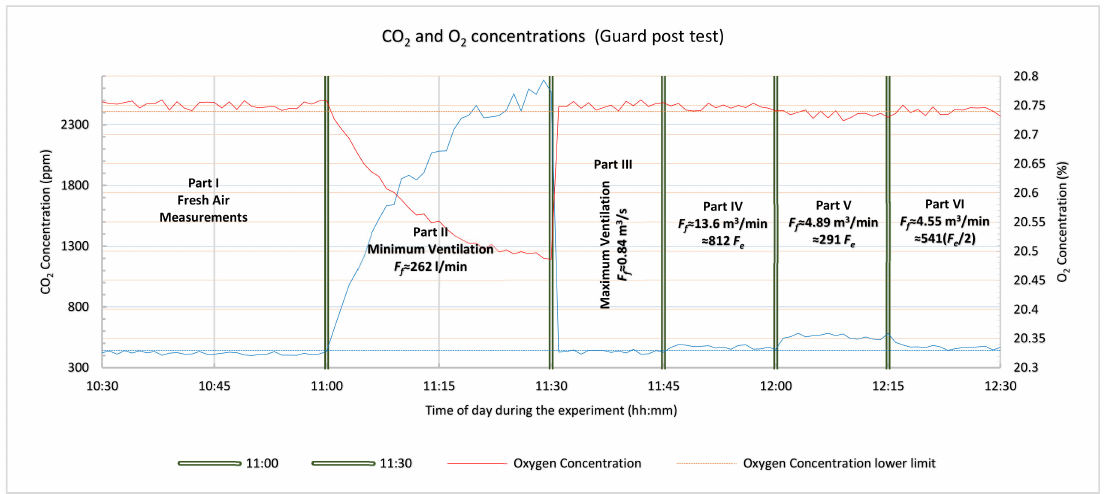
Figure 6. Guard post test